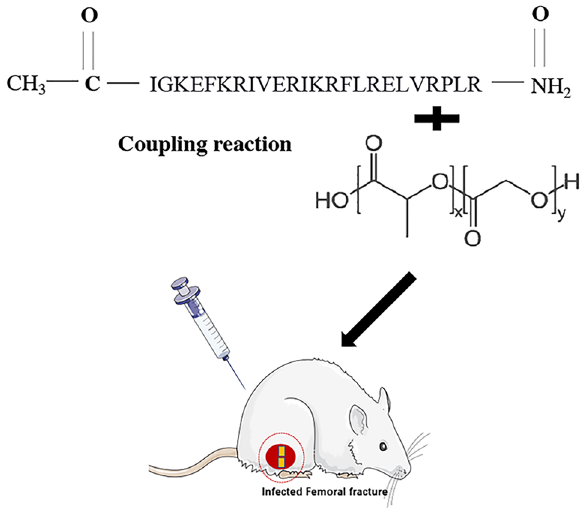
Figure 1. OP-145 was combined with PLGA through the amine coupling reaction for on-demand infected wound